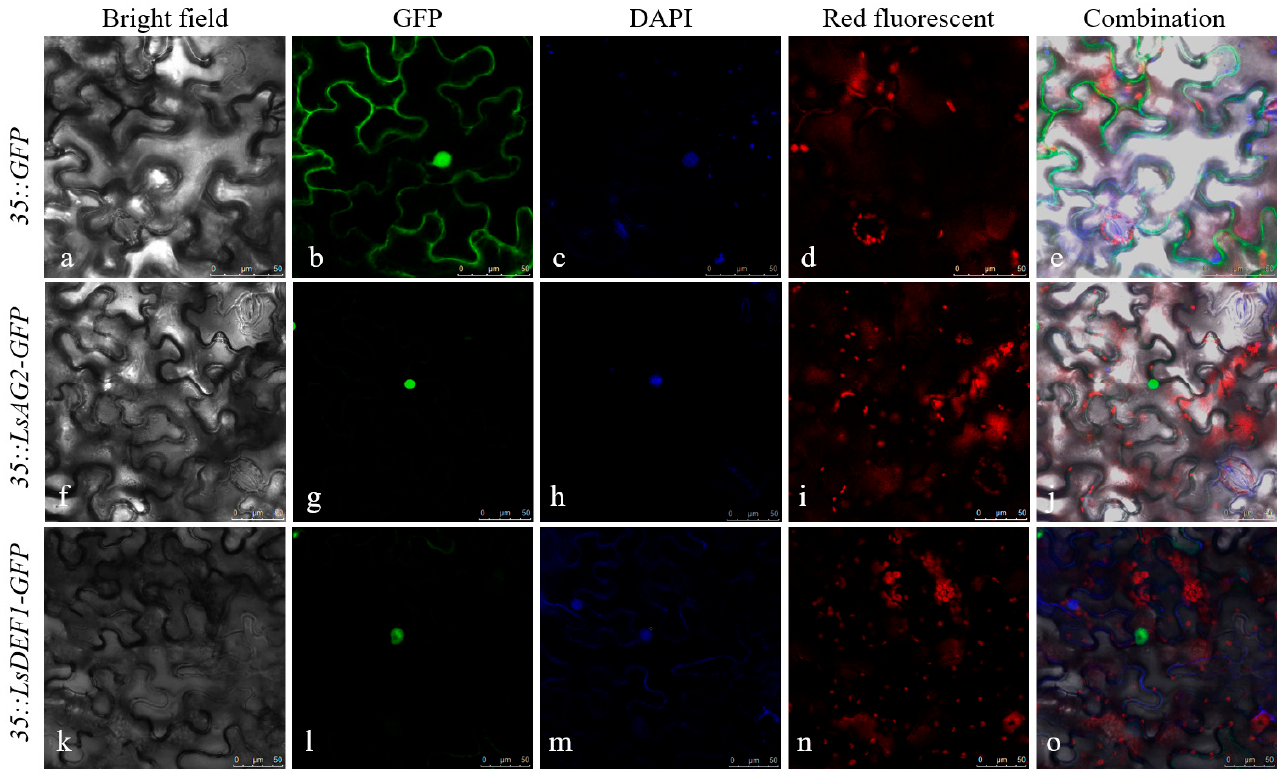
Figure 3. Subcellular localization of LsAG2 and LsDEF1 proteins in tobacco leaf cells. ( a – e ) Subcellular localization of GFP. ( f – j ) Subcellular localization of LsAG2-GFP. ( k – o ) Subcellular localization of LsDEF1-GFP. Bright field: white light. GFP: green fluorescence signal. DAPI: 4 ′ ,6-diamidino-2- phenylindole (DAPI) nuclear DNA fluorescent stain. Red fluorescent: chloroplast auto-fluorescence. Combination: combined signals of different fluorescence.